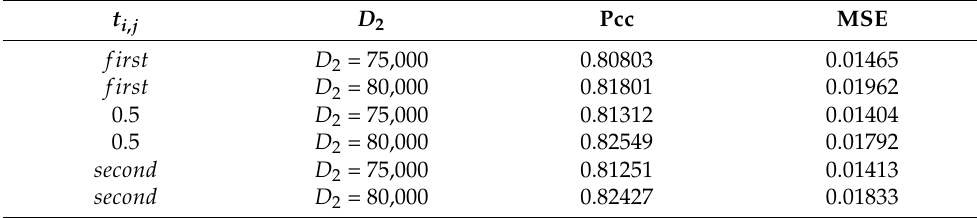
Table 7. Influence of parameters t i , j on sentence semantics of STS’12.surprise.OnWN.txt with the